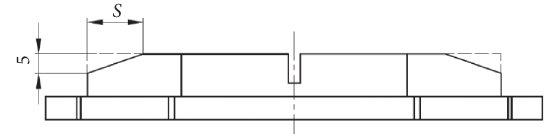
Figure 8: Chamfer optimization parameter for the brake lining.